Question: Which visualization type does this figure use?
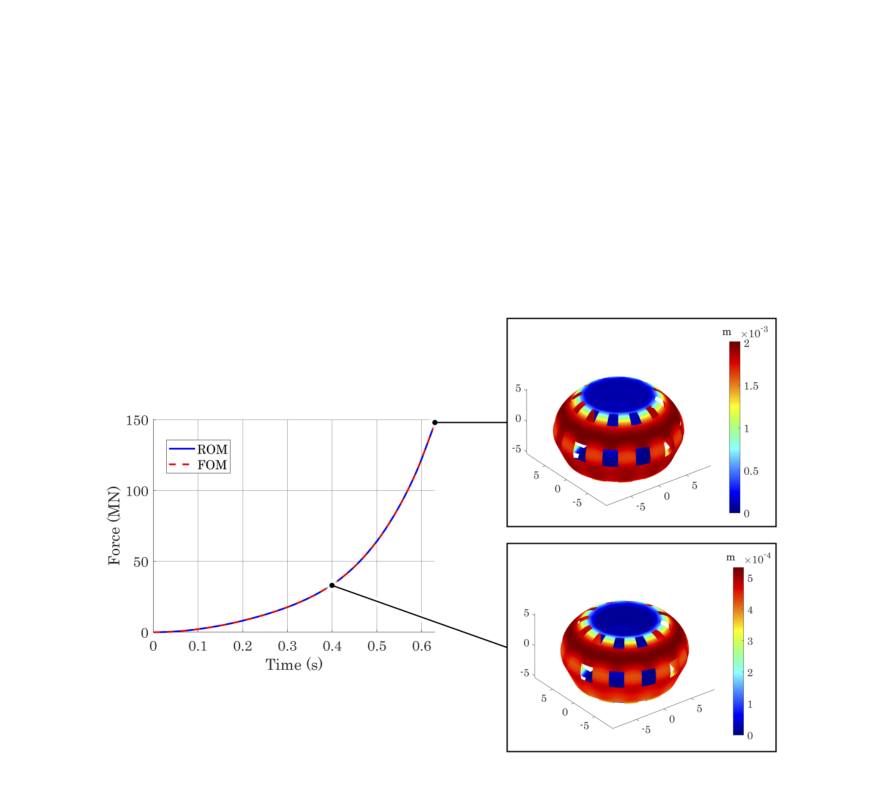
Answer: line